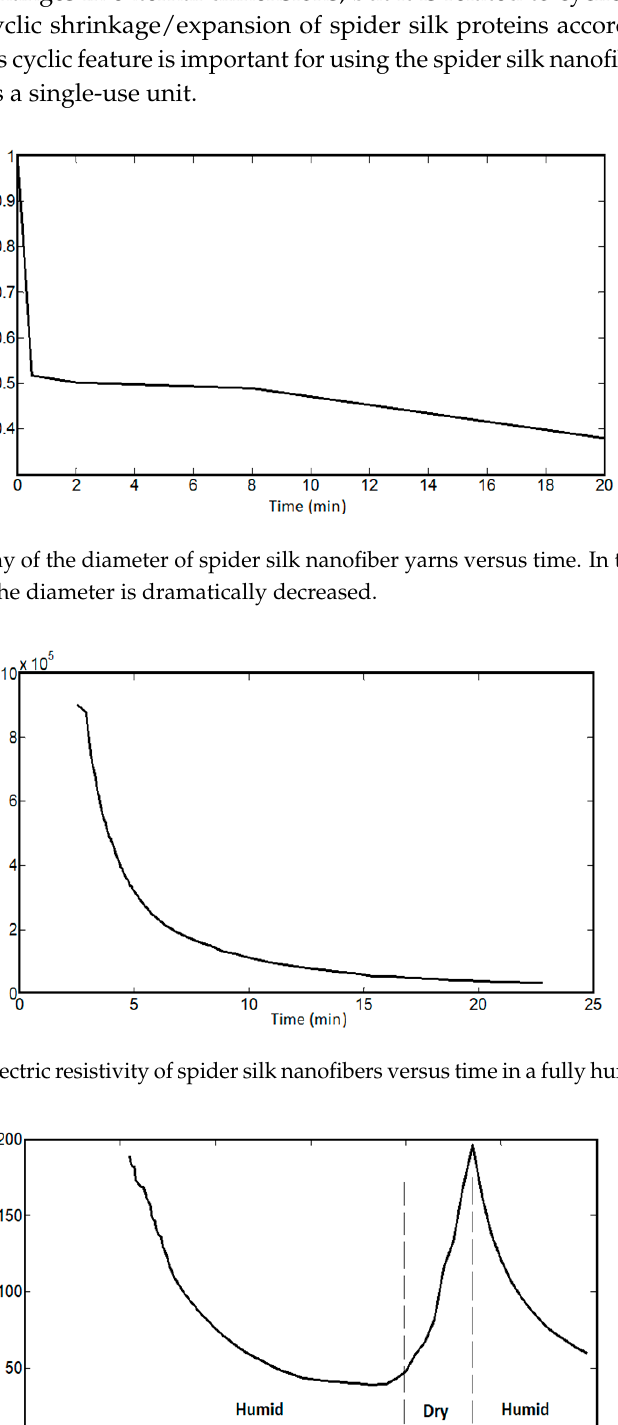
Figure 14. Cyclic resistance of the nanocomposite at RH levels of 90% and 16% (“normal